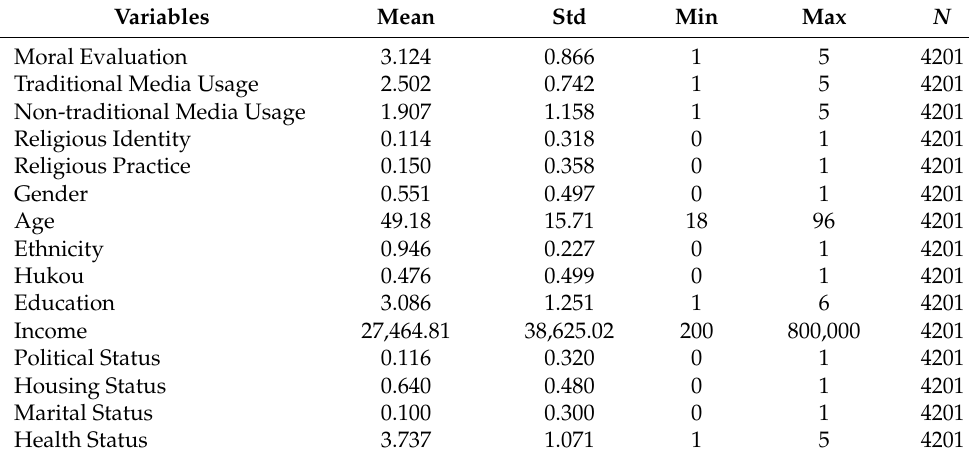
Table 1. The results of summary